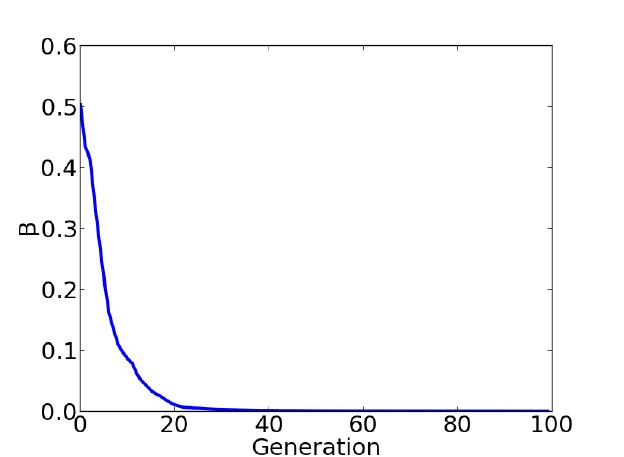
Figure A3. Evolution of the “bad parameter” β , averaged over all individuals in ten independent runs of EMOPaT, versus generation